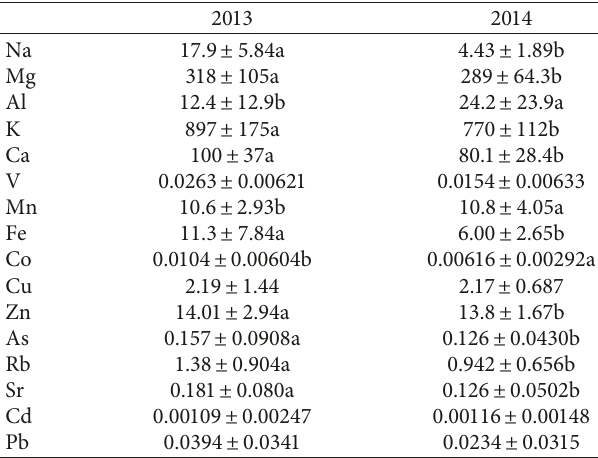
Different letters in rows are statistically significantly different at P < 0 . 05.